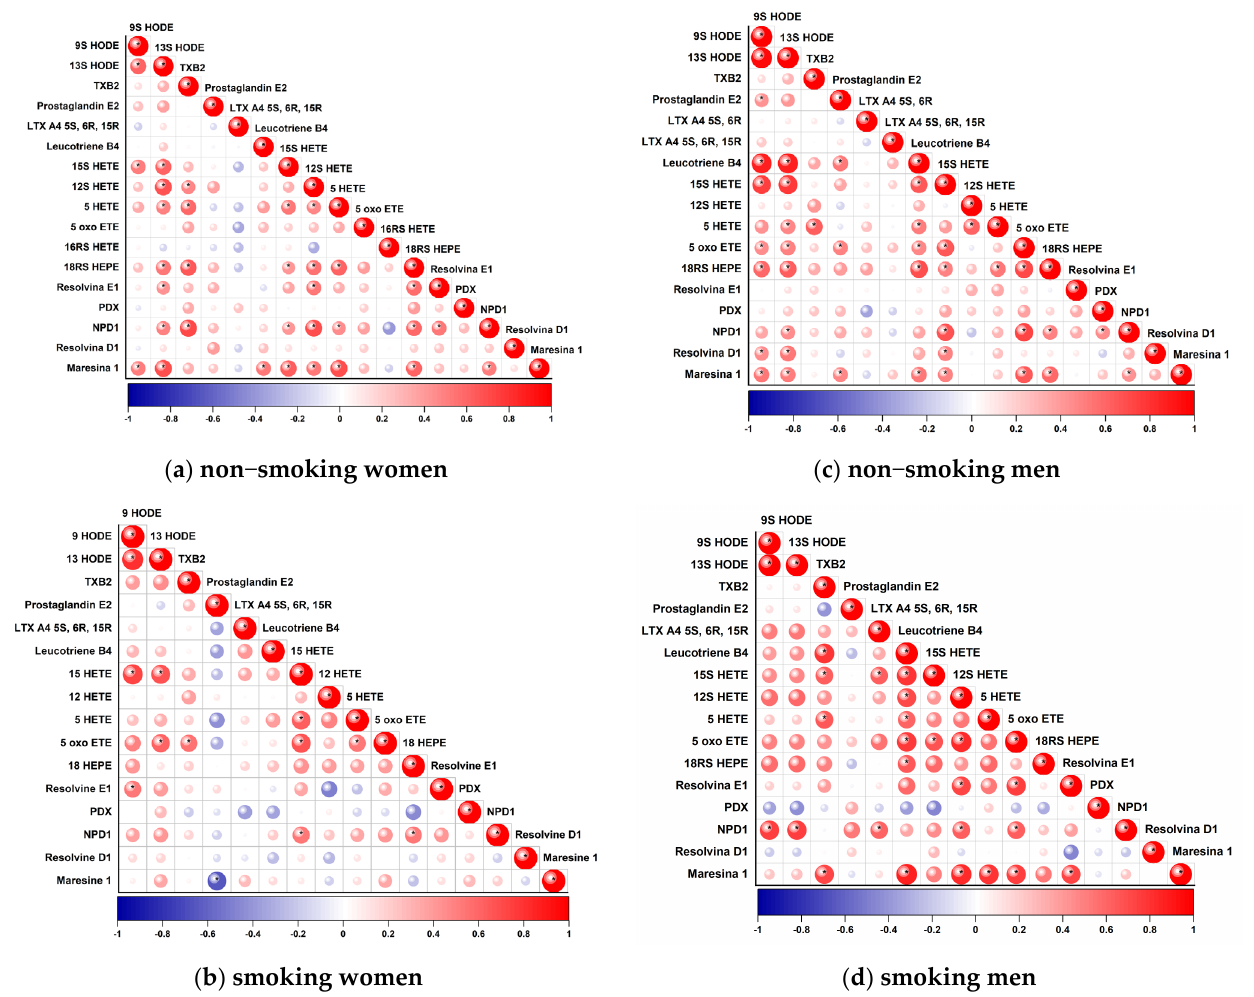
Figure 1. Correlation plot showing correlations between particular eicosanoids in studied groups ( a–d ). Red indicates a positive association; blue indicates an inverse association. Higher color intensity and larger circles indicate stronger associations; lower color intensity and smaller circles indicate weaker associations. Asterisk indicates statistically significant correlations.